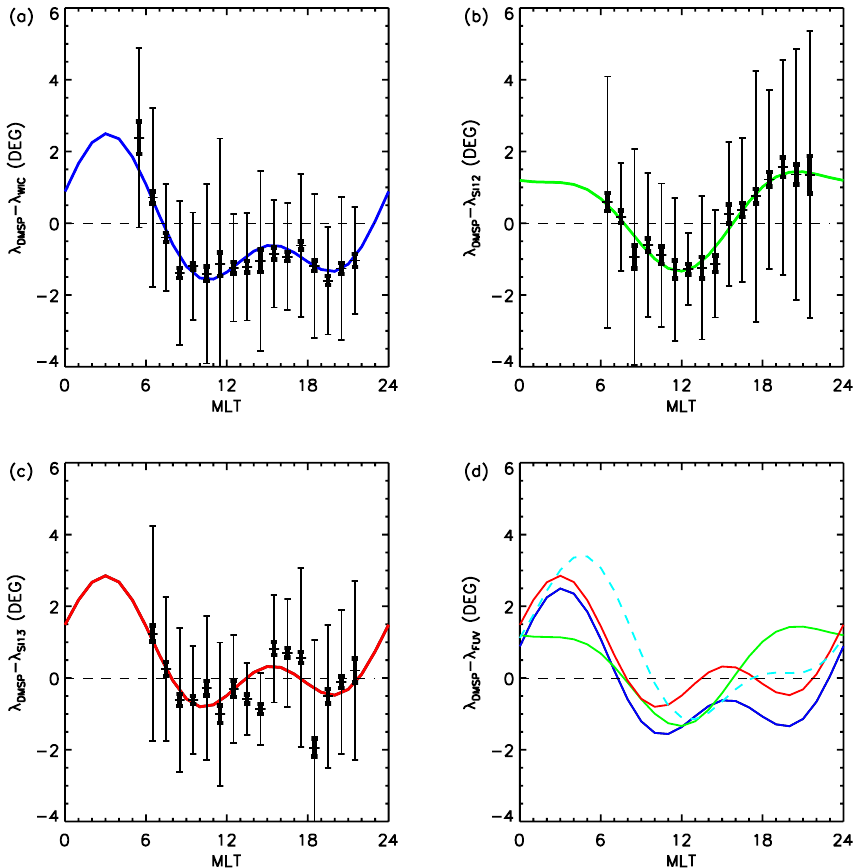
Fig. 5. Modes of OCB proxy latitude differences between FUV and DMSP, (a) λ DMSP − λ WIC , (b) λ DMSP − λ SI − 12 and (c) λ DMSP − λ SI − 13 . Bold error bars represent the estimated error on the mode and thin error bars represent the estimated widths (see text for details). Second order harmonic fits to the OCB proxy latitude differences are shown by solid curves and compared to the fit of Carbary et al. (2003) (dashed light blue line) in panel (d)